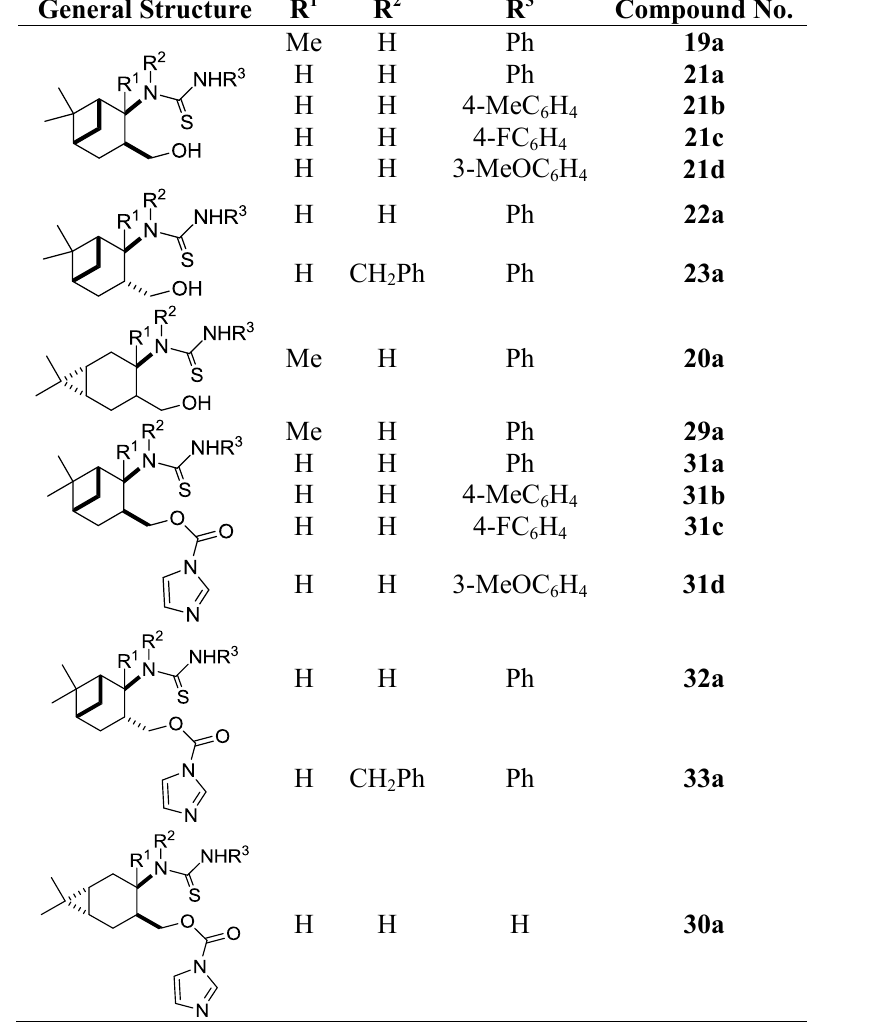
Table 1. Thioureas 19 – 23 and O -imidazolylcarbonyl intermediates 29 – 33 . General Structure R 1 R 2 R 3 Compound